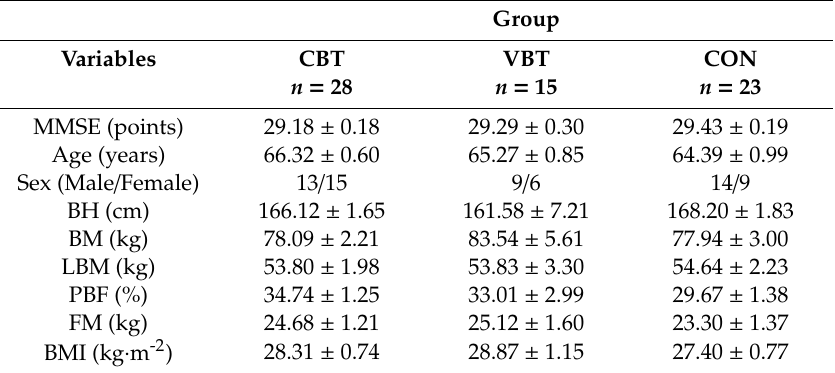
Table 1. Baseline characteristics of the groups.